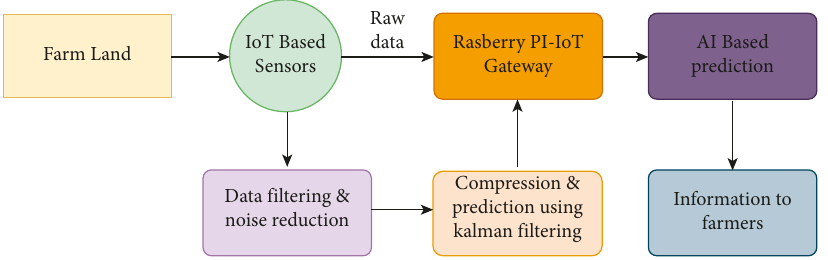
Figure 1: IoT-based system